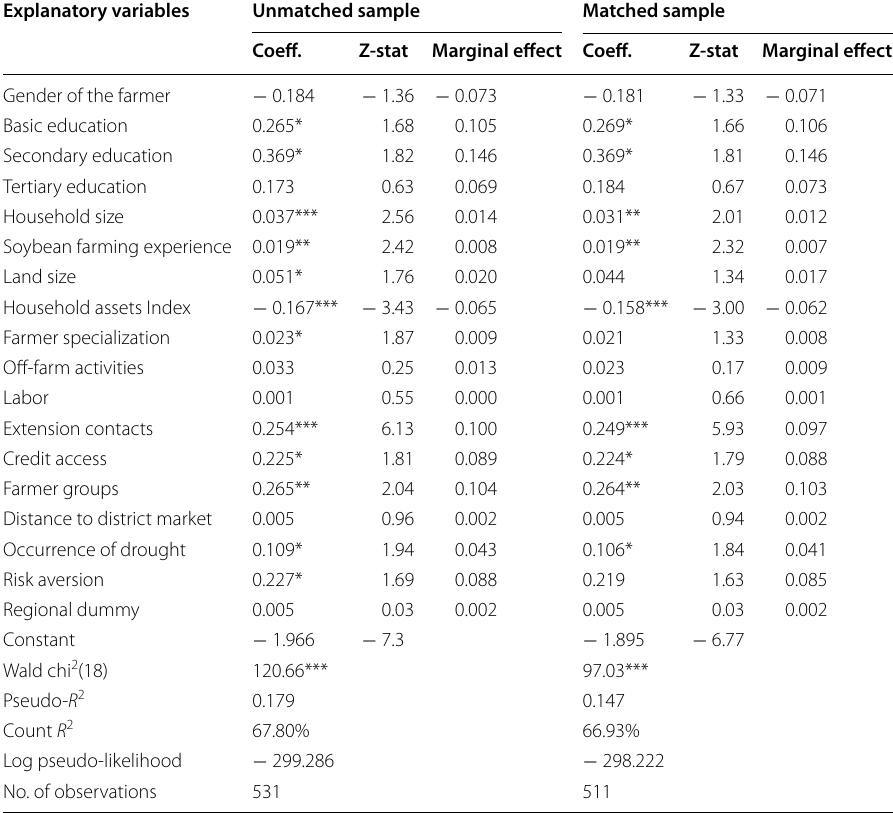
***, **, and * denote significance at 1%, 5%, and 10% levels, respectively